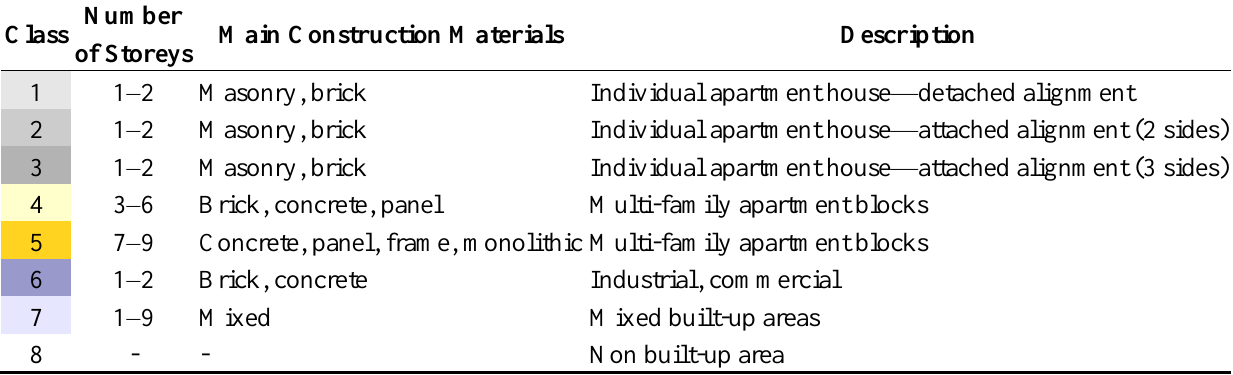
Table 1. List of identified predominant building types for Bishkek.